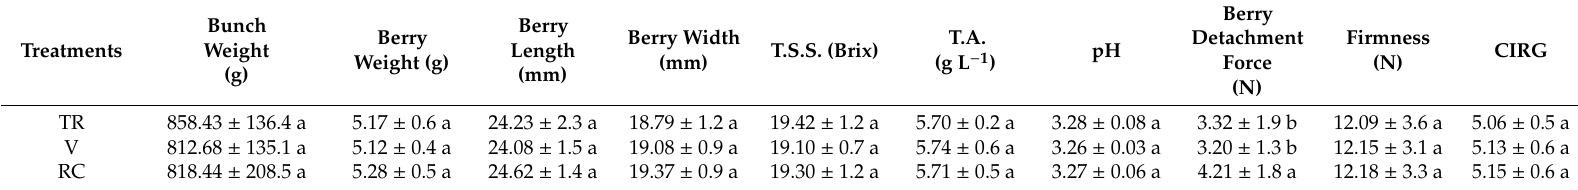
Table 2. Soil management e ff ects on cluster and berry parameters in 2015–2016. (Values are means ±